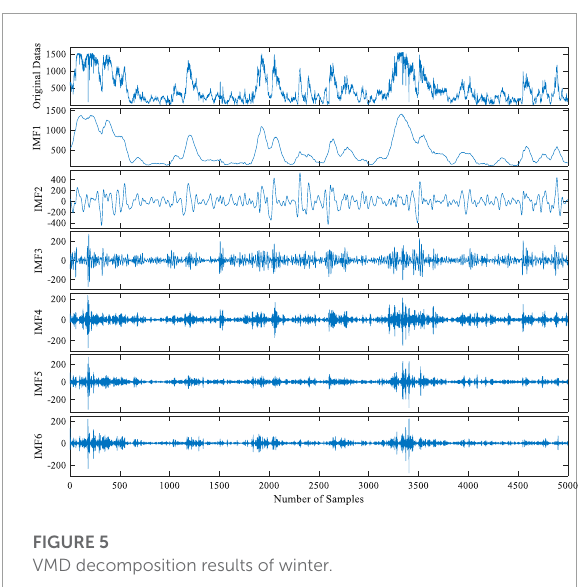
FIGURE 5 VMD decomposition results of